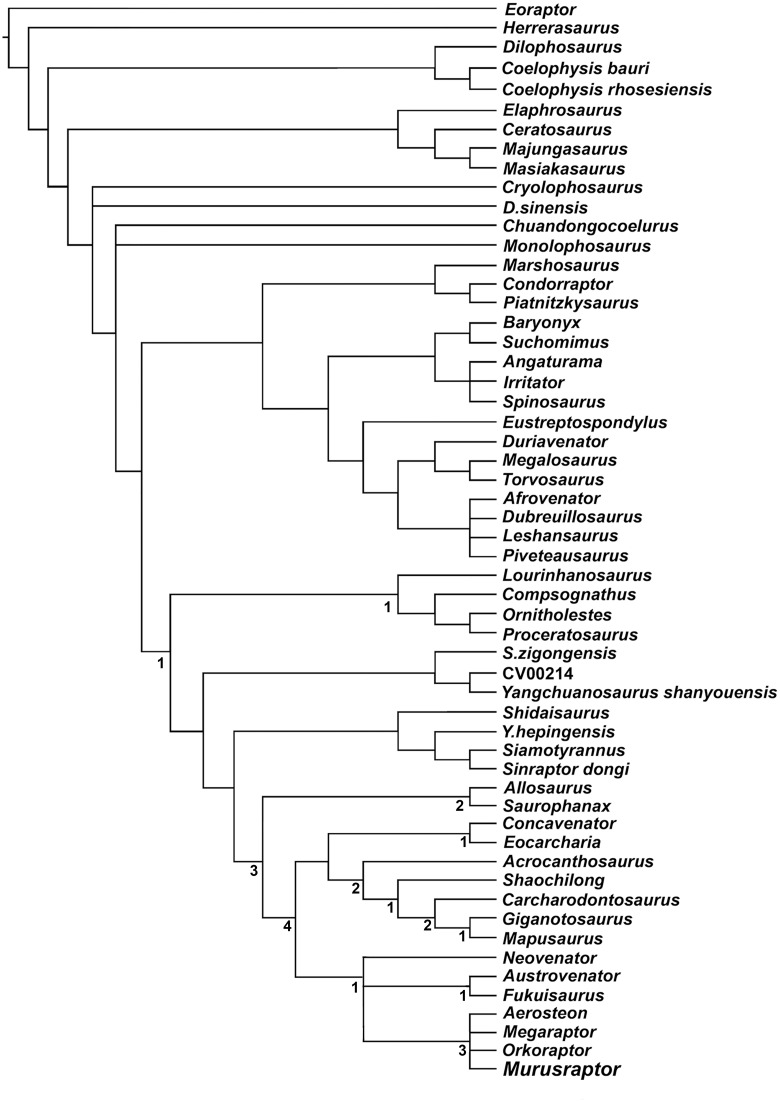
Cladogram depicting the phylogenetic position of Murusraptor according Analysis A.Numbers in nodes indicate Bremer support.